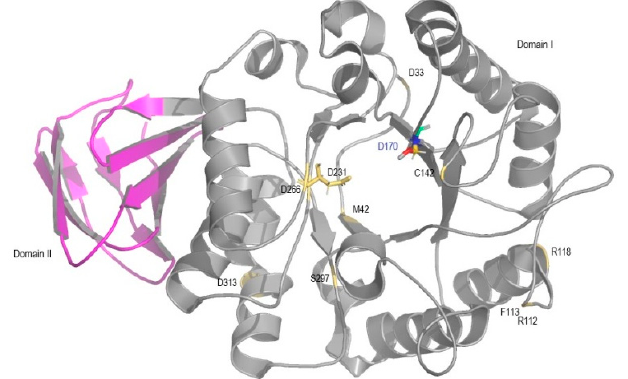
Figure 2. Location of α -GAL missense mutations considered in this study presented in a solid ribbon model. Domain I is shown in grey and domain II is shown in pink. Mutations are identified in yellow, and active site residues (D170 and D231, the non-mutated active site residue in blue letters) are shown as ball-and-stick model, with different colors.